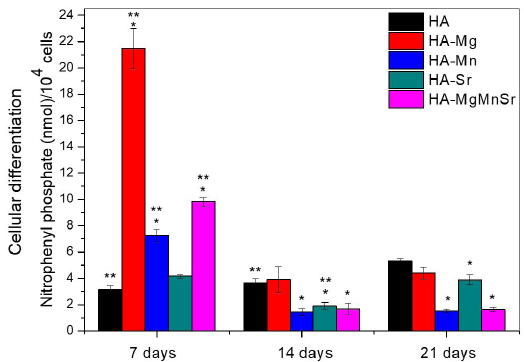
Figure 7. Cell differentiation of MC3T3-E1 on original and doped samples. *Significantly different from the HA sample at the same time point. **Significant difference between similar samples relative to the last time point (21